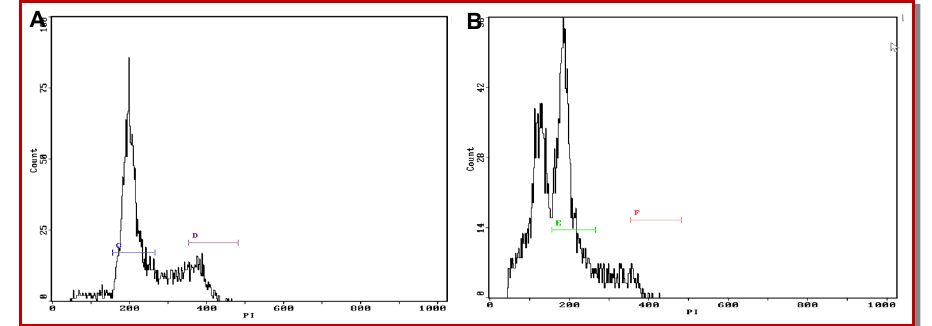
Figure 4: Detection of apoptotic cells by flow cytometry. An apoptotic peak was found before G1 phase. (A) control; (B) ASODN group